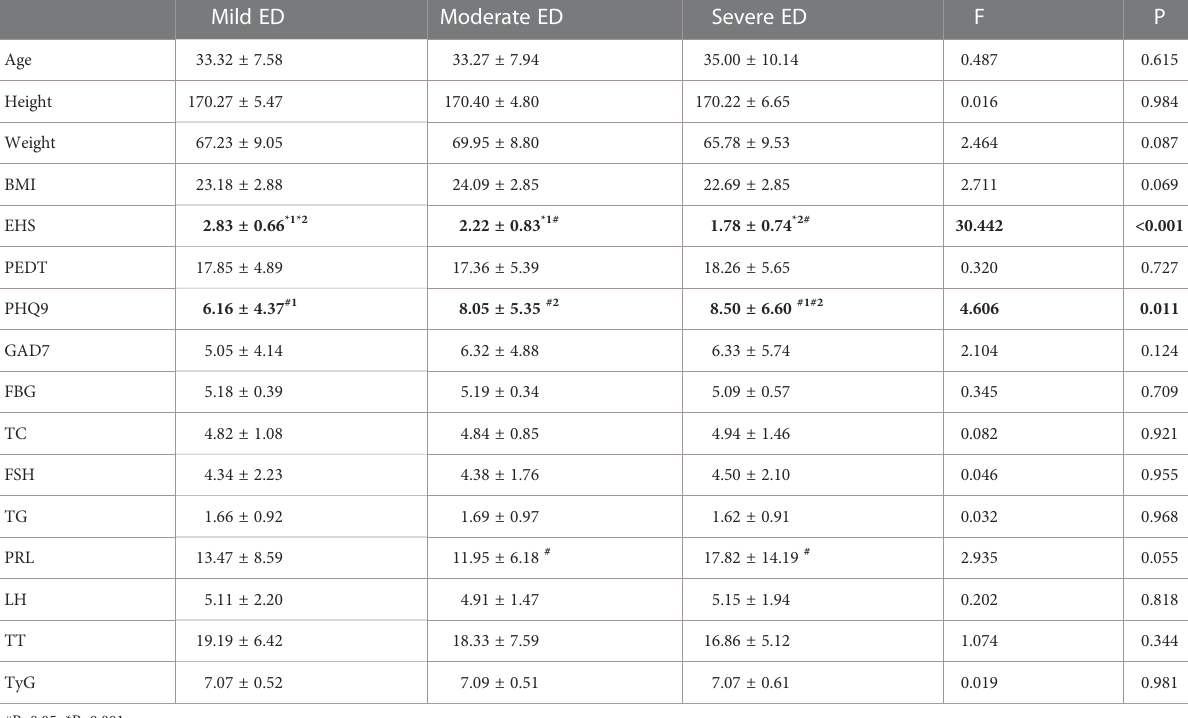
TABLE 3.2 The Results of LSD Among Mild ED, Moderate ED and Severe ED in Non-DMED Populations. Mild ED Moderate ED Severe ED